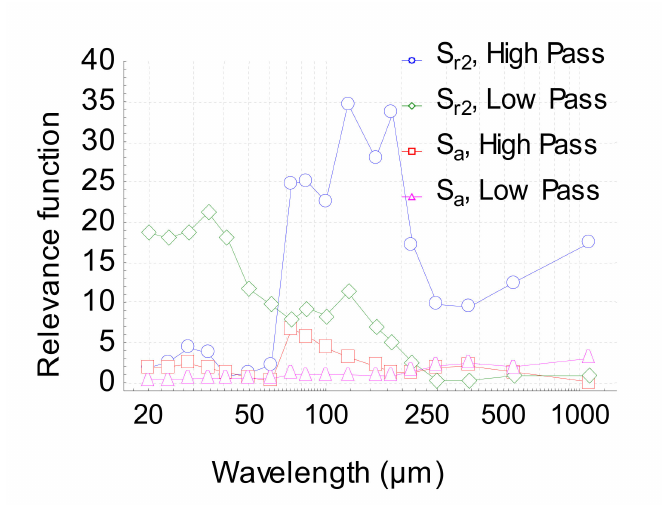
(cid:16) (cid:17) S k , ε , λ , p i versus the wavelength for both parameters S r2